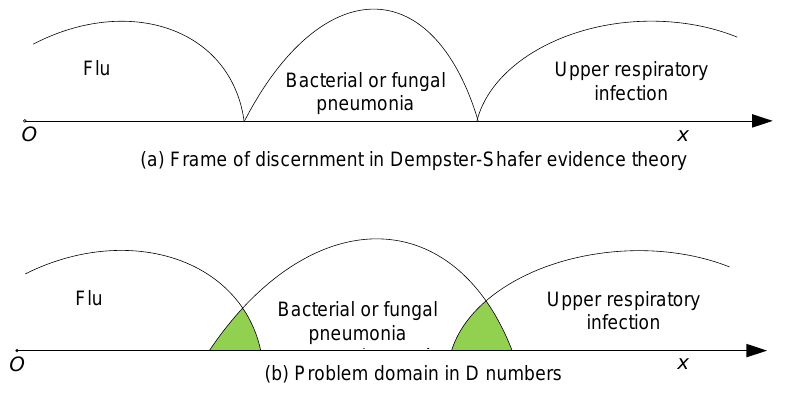
Figure 1. The frame of discernment in Dempster–Shafer evidence theory (DST) and in D numbers.